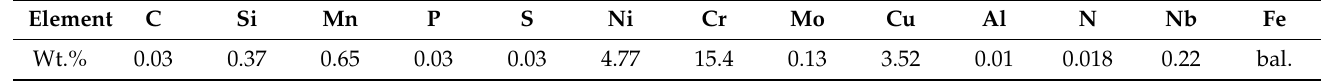
Table 1. Chemical composition of 17-4 PH SS (wt.%) by